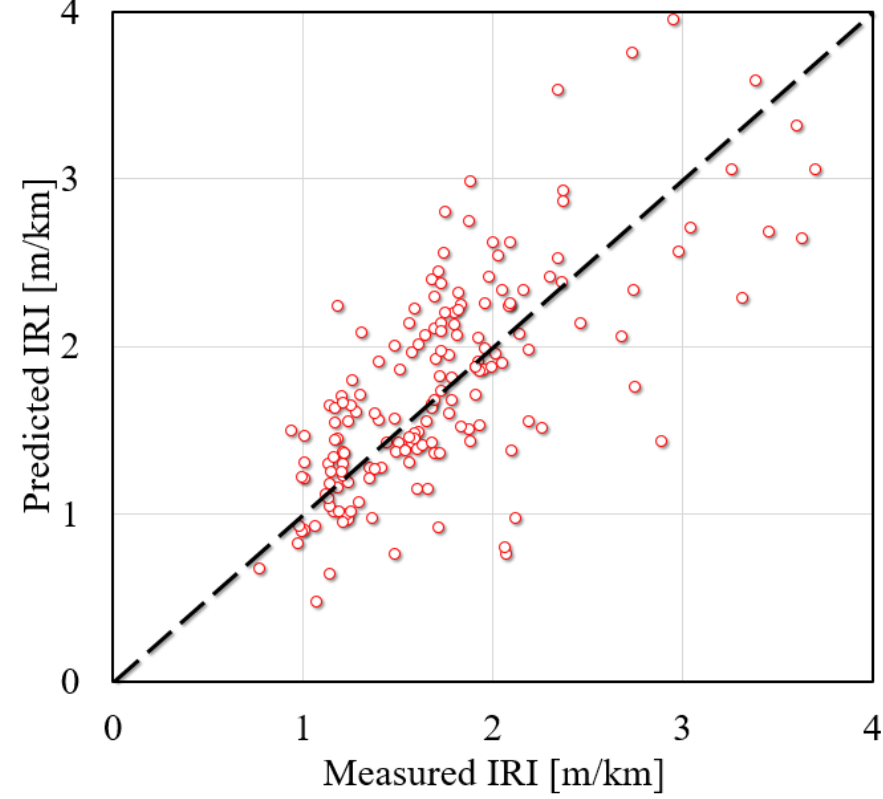
Figure 1. Comparison of the predicted and measured IRI results [28].